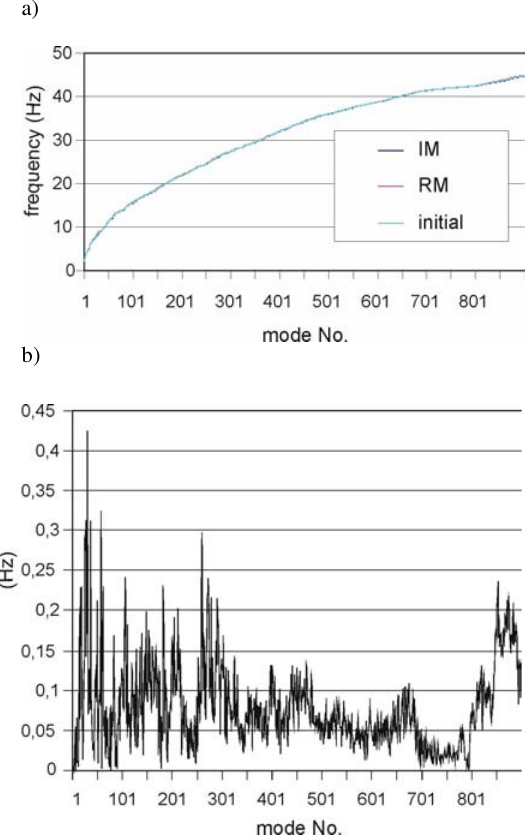
Fig. 9. Comparison of frequencies (a) and absolute differ- ence between frequencies (b) obtained for different mod- els